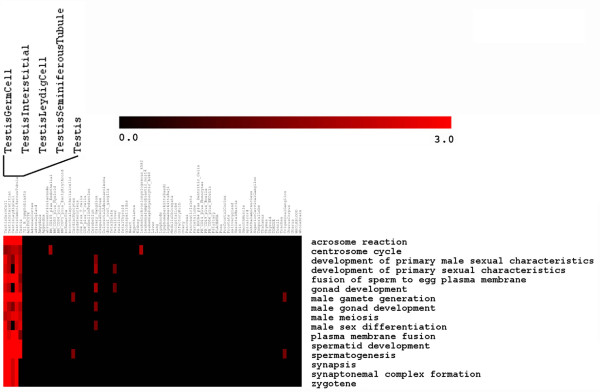
An example of pathway pattern extraction results in a heatmap. The data of patterned GO biological process terms for GNF dataset [43] was obtained with pathway pattern extraction, whose extraction template was set as shown in Figure 3: look for patterned terms that are enriched in at least 4 of 5 Inclusion samples (testis-related tissues: testis germ cells, testis interstitial, testis leydig cells, testis seminiferous tubule, testis), but not enriched in at least 72 of 74 Exclusion samples (the rest of tissues in GNF dataset).